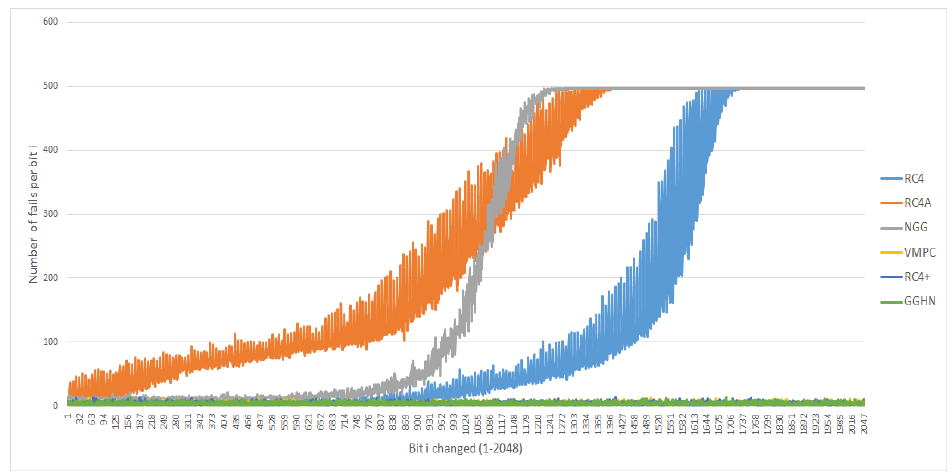
Figure 2. Distribution of the fails per bit changed in BIC for n = 2048, m = 32, and l = 16,384.